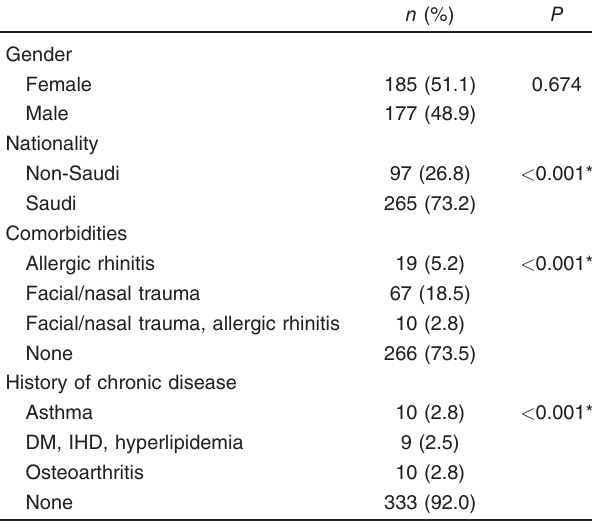
Table 1 Demographic factors of the studied patients ( n =